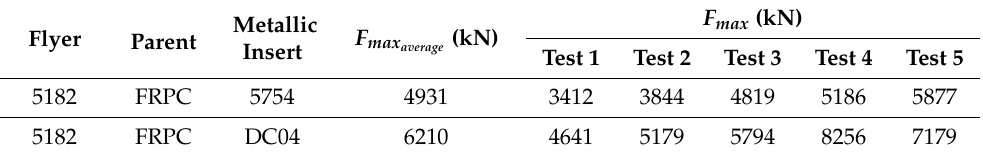
Table 8. Fatigue tests results for metallic insert configuration (E = 16 kJ).